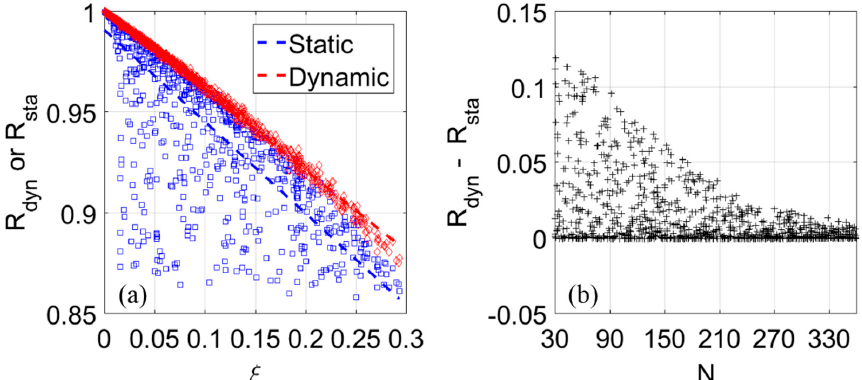
Figure 5. Results from the simulation experiment. ( a ) The x-axis indicates Euclidean distances ( ξ ) calculated by Equation (7), representing the qualities of the parent products, and the y-axis, R dyn or R sta . The dashed two lines present the linear regression of all results from the dynamic and static combinations, respectively; ( b ) The x-axis indicates N sizes, the y-axis differences between R dyn and R sta ( i.e ., R dyn ´ R sta ).